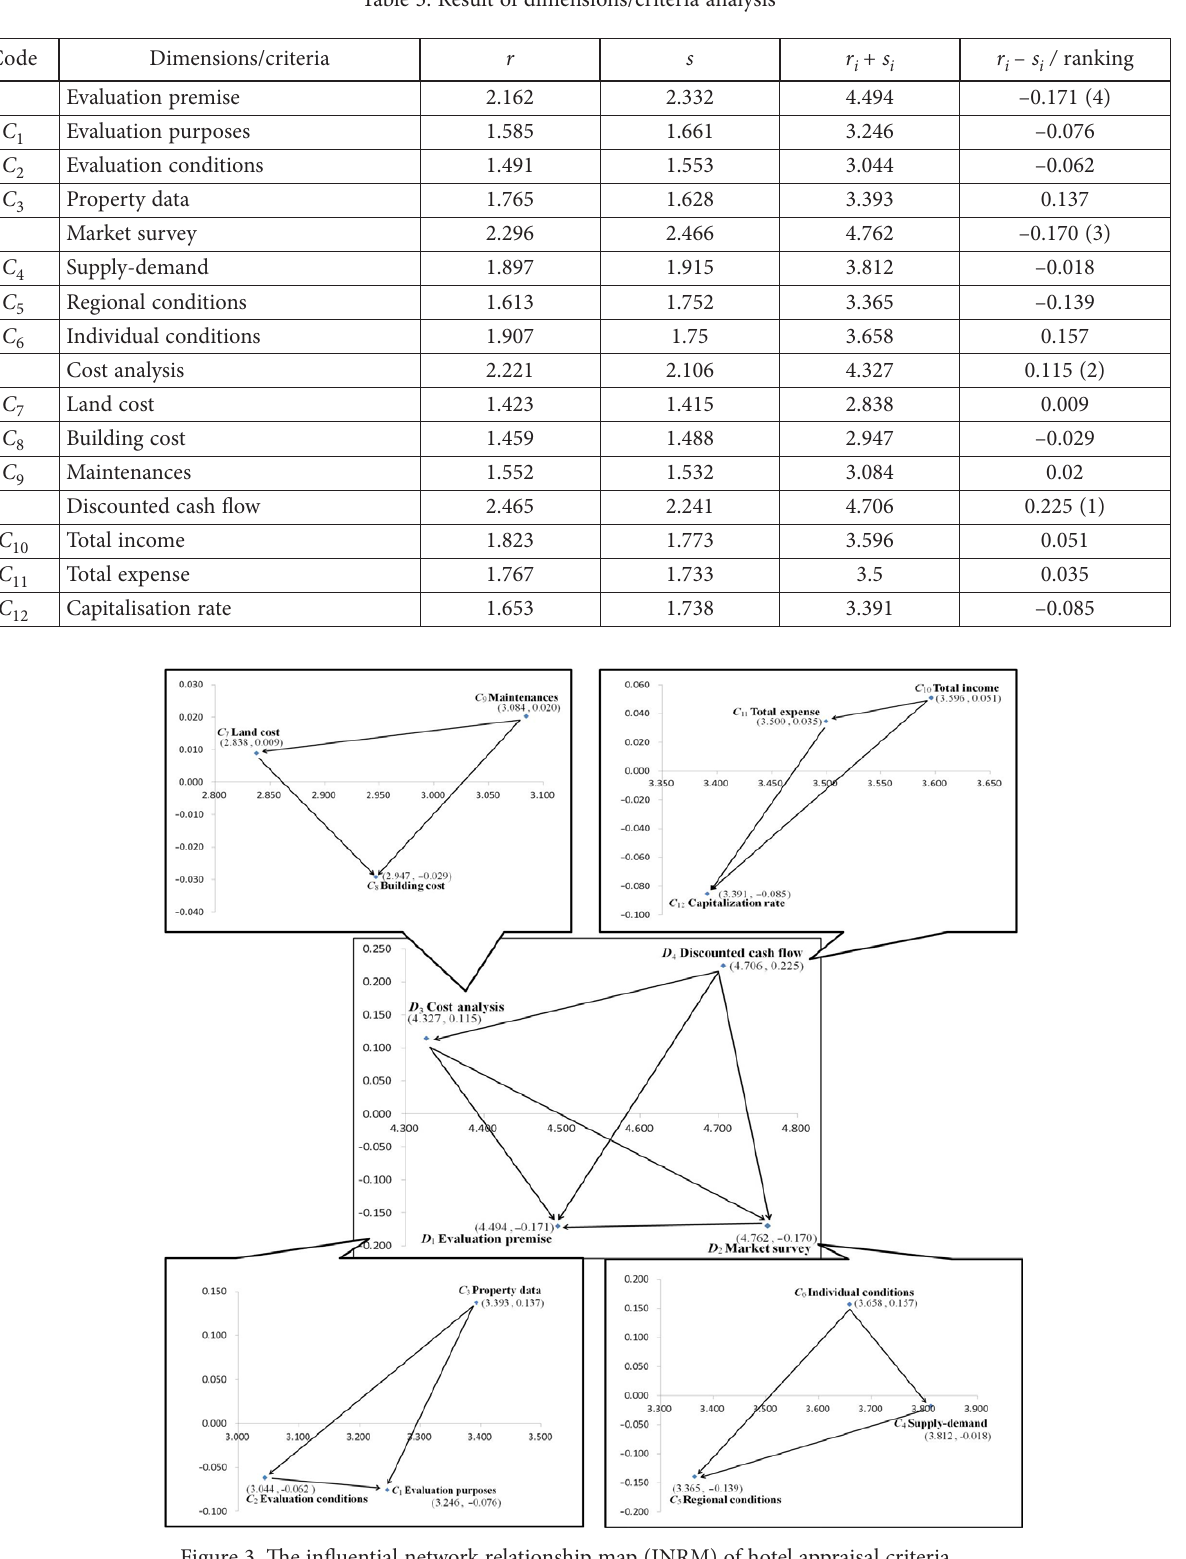
Figure 3. The influential network relationship map (INRM) of hotel appraisal